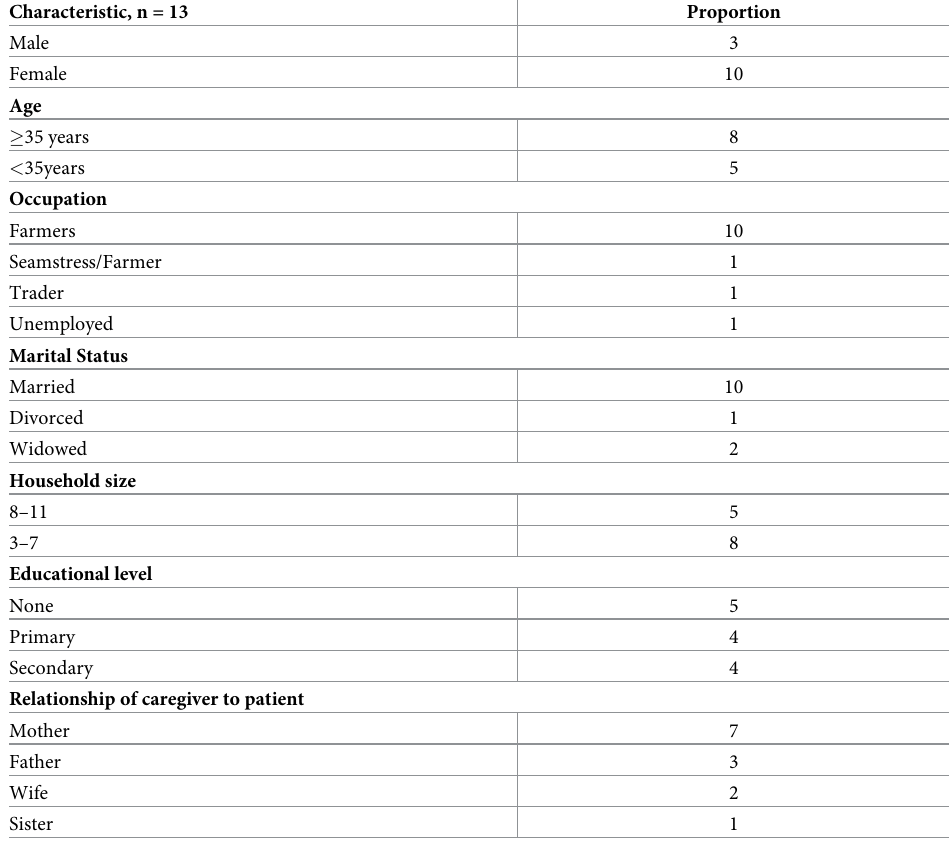
Table 1. Socio-demographic characteristics of caregivers of patients with